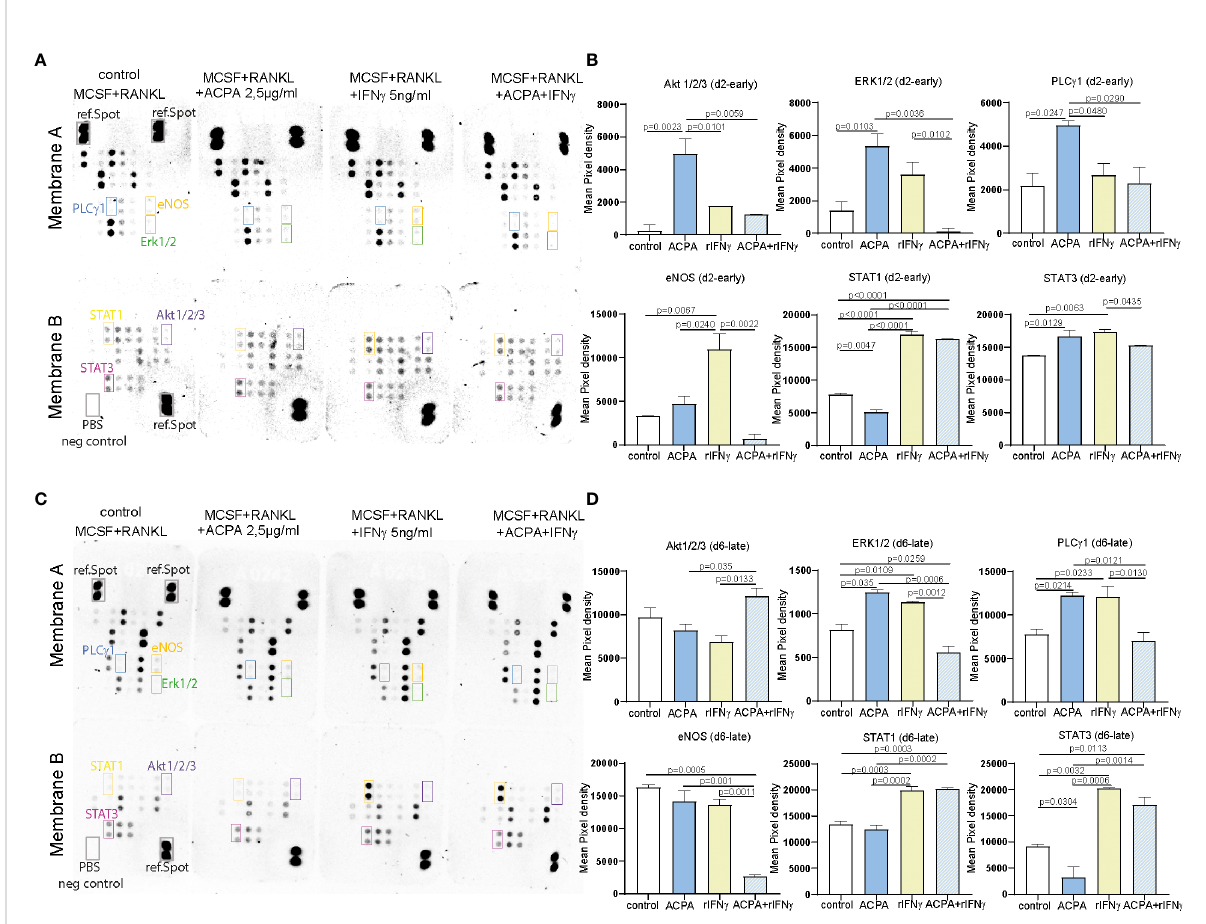
FIGURE 3 Fc g R and IFN g R stimulation in fl uences MAPK signaling dependent on the stage of osteoclast differentiation. Representative pictures (A) and calculation of the integrated pixel density of selected spots (B) of membranes A and B of the human phosphokinase array developed for 30 min. The membranes were incubated with 150 µg of protein lysates from day 2 osteoclast precursors supplemented with 2.5 µg of antibodies against citrullinated proteins (ACPAs), 5 ng of IFN g , or a combination of 2.5 µg of ACPA and 5 ng of IFN g for 1 h compared to non-supplemented controls (M-CSF+RANKL). Representative pictures (C) and calculation of the integrated pixel density of selected spots (D) of membranes A and B of the human phosphokinase array developed for 30 min. The membranes were incubated with 150 µg of protein lysates from day 6 premature osteoclasts supplemented with 2.5 µg of ACPA, 5 ng of IFN g , or a combination of 2.5 µg of ACPA and 5 ng of IFN g for 1 h compared to non-supplemented controls (M-CSF+RANKL). Data are the mean − /+ s.d. One-way ANOVA was used for the analysis, and the corresponding p -values are indicated in the fi